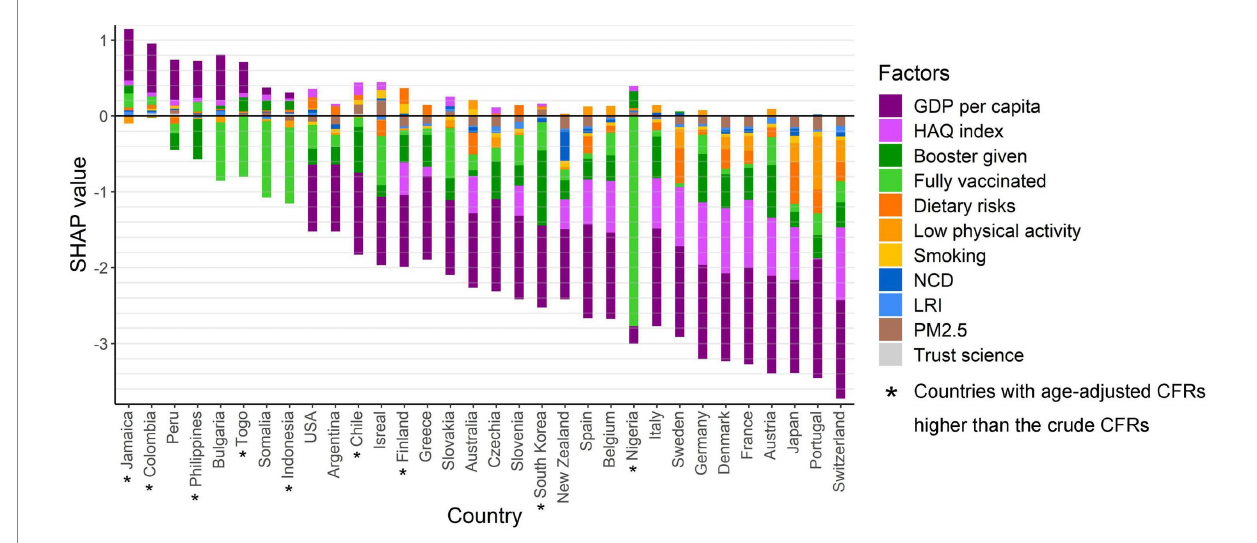
FIGURE 4 The protection and risk contributions of the determinants of the COVID-19 age-adjusted CFR for each country in the Omicron period. SHAP values above 0 are regarded as risk effects and below 0 as protective